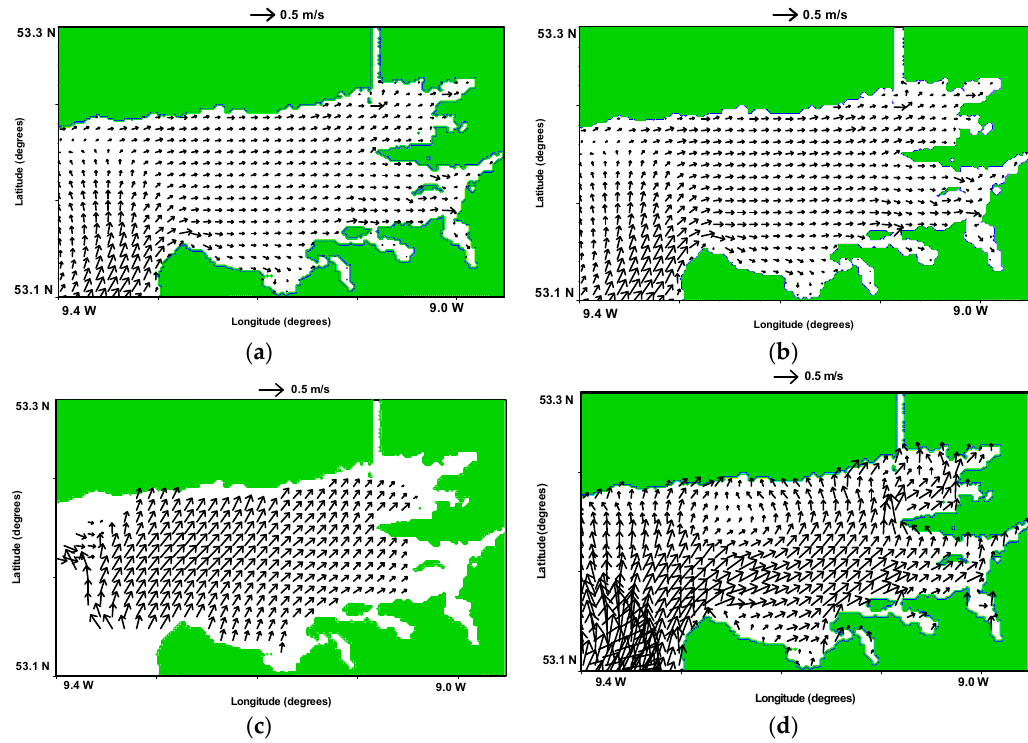
Figure 16. Mid-flood vector fields (( a ) Depth-averaged currents from model NW; ( b ) surface currents from model NW; ( c ) CODAR current data and ( d ) surface currents from model HR).